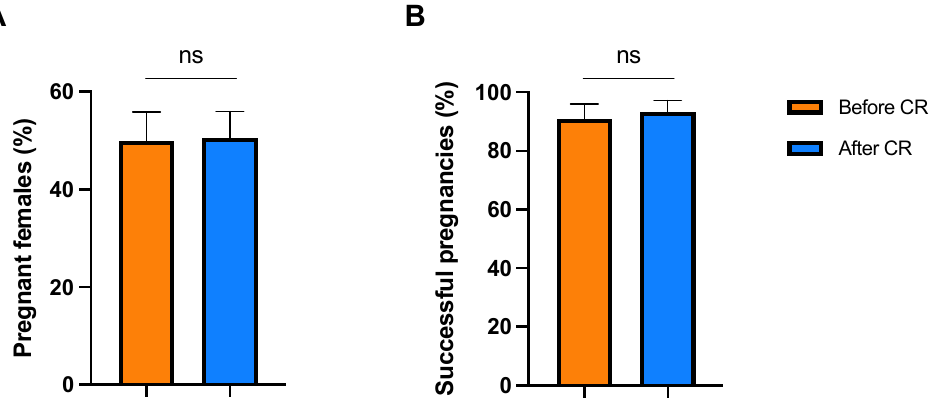
Figure 4. Proportion of pregnant females ( A ) and successful pregnancies ( B ) in a long-tailed macaque breeding colony before and after caloric restriction (CR). Error bars represent the standard error. ns: p ≥ 0.05.